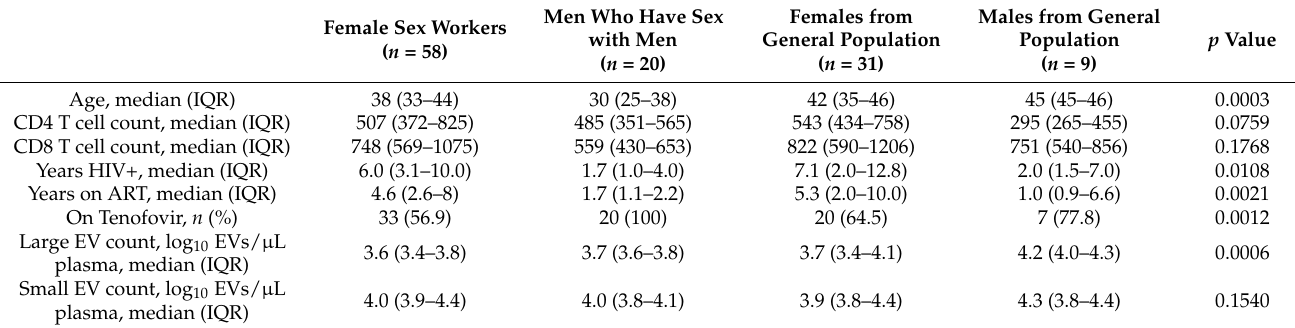
Table 2. Characteristics of non-viremic participants.